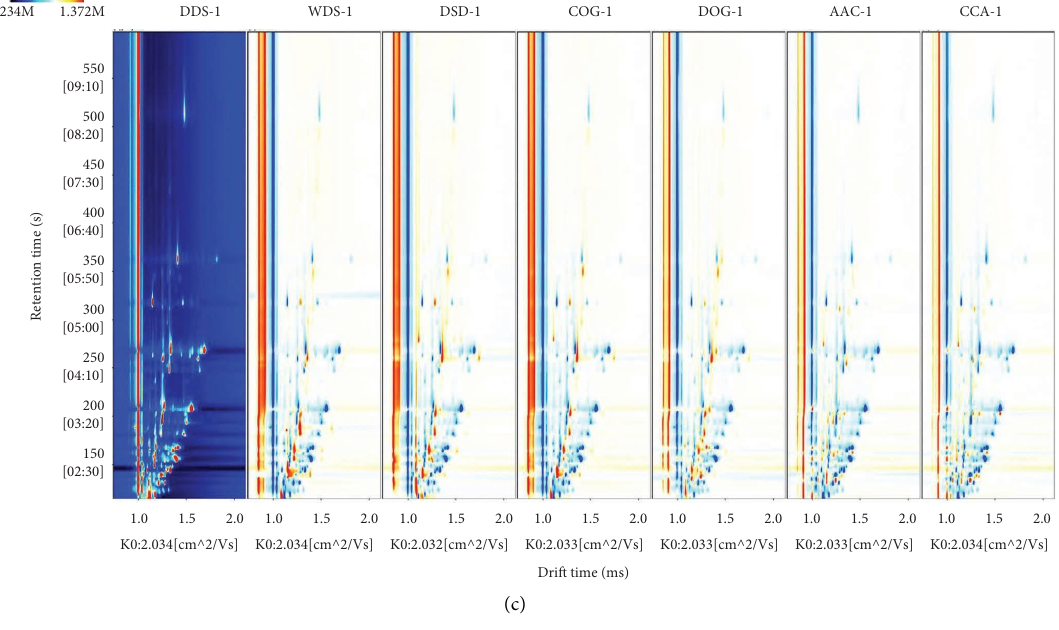
Figure 2: (a) 3D top view spectra and (b) 2D spectra of volatile favor compounds in Ejiao at diferent processing stages. (c) Diference spectra of volatile favor compounds in Ejiao at diferent processing